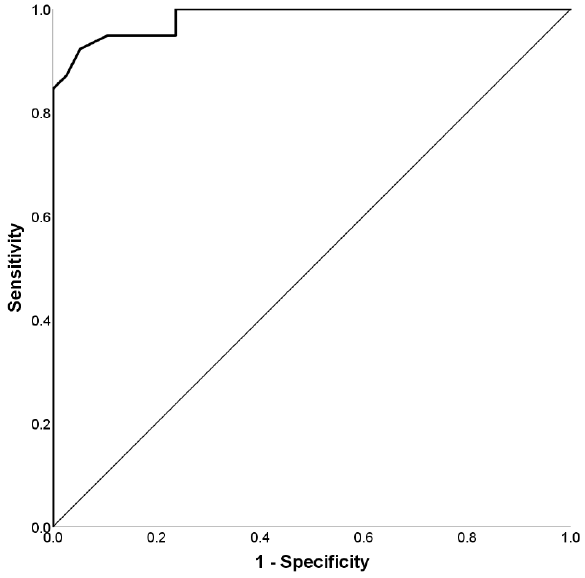
Figure 4. ROC curves for differentiating simulators and honest controls using the MPMT (AUC = 0.98). Note: AUC = area under the curve; ROC = receiver operating characteristic. Correspondingly, the simulators performed more poorly than honest controls in the MPMT, as is evident by the ANOVA’s significant group main-effect ( F (1,75) = 168.87, p < 0.001, η p ² = 0.69). Importantly, the group x level interaction was significant ( F (2,150) = 5.78, p = .004, η p ² = 0.07). Post-hoc analyses indicated that the accuracy of honest controls de- clined between levels 1 and 2 ( t (37) = 2.55, p = 0.015) and between levels 1 and 3 ( t (37) = 4.21, p < 0.001), but did not significantly change between levels 2 and 3 ( p = 0.383). In con- trast, the performance of simulators essentially did not change across the levels. The block and level main effects were not significant ( p = 0.352, p = 0.095; respectively). No other significant main effects or interactions were found in the ANOVA; see Figure 5.